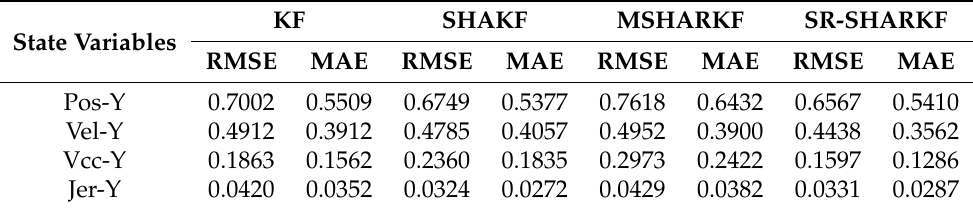
Figure 8. Dynamic parameter error in the Y-axis direction. ( a ) Position error. ( b ) Velocity error. ( c ) Acceleration error. ( d ) Jerk error. Table 4. Dynamic parameter error evaluation in the Y-axis